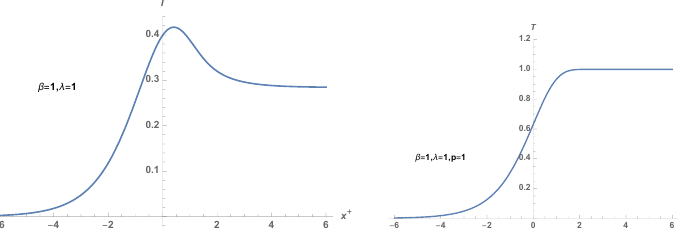
Figure 29 . Evolution of the tachyon for the lightlike rolling tachyon deformation, left as given in [59], and right from the shifted 3-point